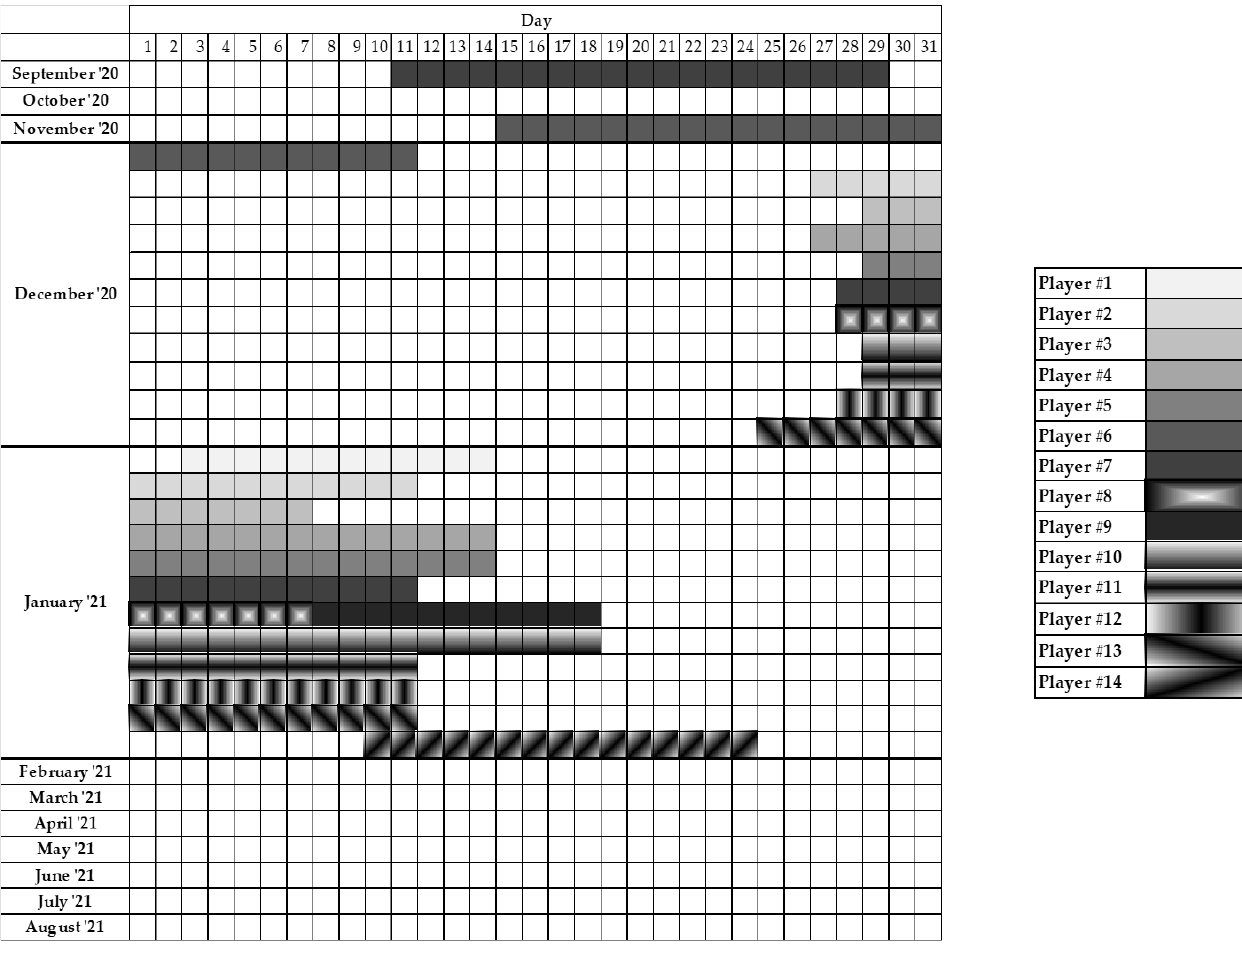
Figure 1. Duration and evolution of COVID-19 infection in professional football players during the 2020–2021 season. 2020–2021